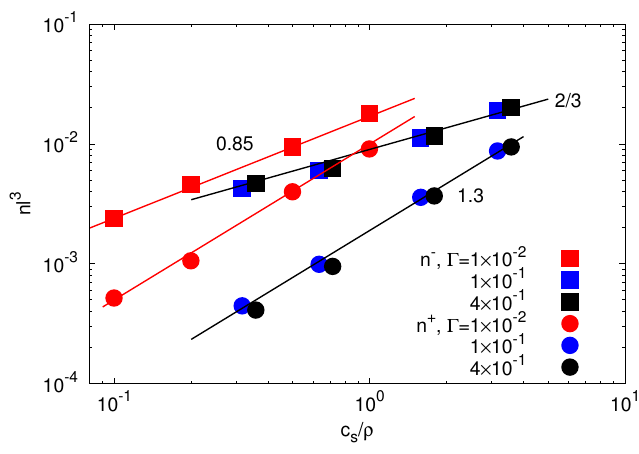
Figure 6. Density of ions inside a microgel as a function of the salt concentration for microgels with N c = 147 and L / l = 200 and the indicated interaction strengths. The squares represent the total concentration of negatively-charged ions, i.e., counterions plus salt ions. The bullets represent the positively-charged salt ions.